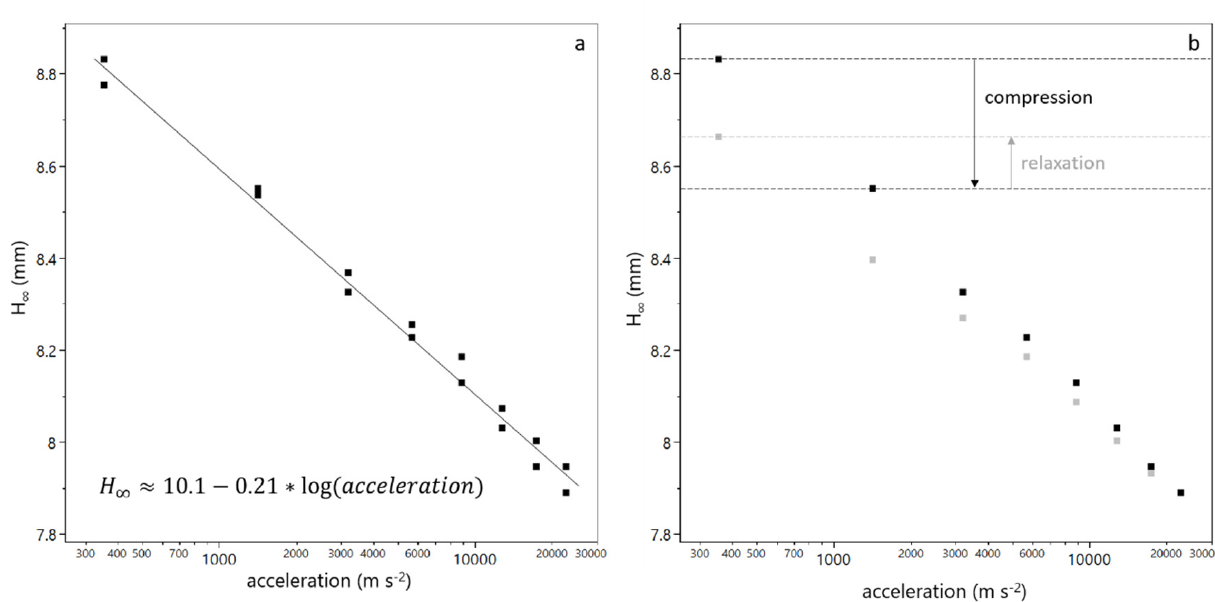
Figure 2. Equilibrium sediment bed height as a function of the centrifugal acceleration. The decreasing bed height with increasing acceleration can be fitted as a semi-logarithmic function for each duplicate measurement ( a ). After a step with reduced acceleration, the sediment bed height increases, which indicates a relaxation of the sediment ( b ). The black dots refer to values obtained from compression steps and grey dots to values obtained from decompression steps. The ratio of relaxation to compression is used to calculate the relaxation factor according to Equation (4).